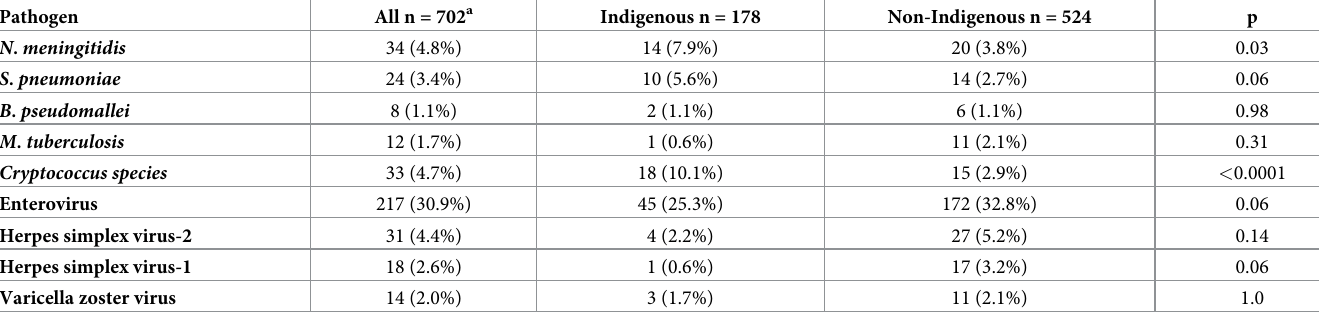
Table 3. The number of cases in Indigenous and non-Indigenous Australians by pathogen.